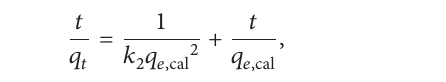
According to Table 5, the correlation coefficients (𝑅 2 ) of the pseudo-second-order kinetic model for the linear plots are higher than 0.99 for all the temperatures and concentrations. On the other hand, when 𝑅 values of the pseudo-second-order kinetic model are calculated from the 𝑅 2 values, it is clearly shown that 𝑅 values for all the temperatures and concentrations are higher than 0.9999 and at the same time are higher than the 𝑅 values of the pseudo- ) adsorption first-order kinetic model. The calculated ( 𝑞 𝑒, cal amount for the pseudo second-order kinetic model is close